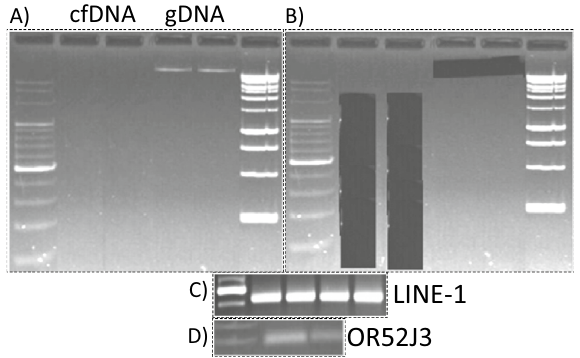
Figure 2. Excision of invisible cfDNA and MSPCR amplification of repetitive and single genomic segments. CfDNA and cellular DNA (gDNA) isolated from young and older individuals were excised from agarose gels after electrophoretic separation ( A / B ), bisulfite treated, and LINE-1 and OR52J3 promoter amplification products were generated ( C / D